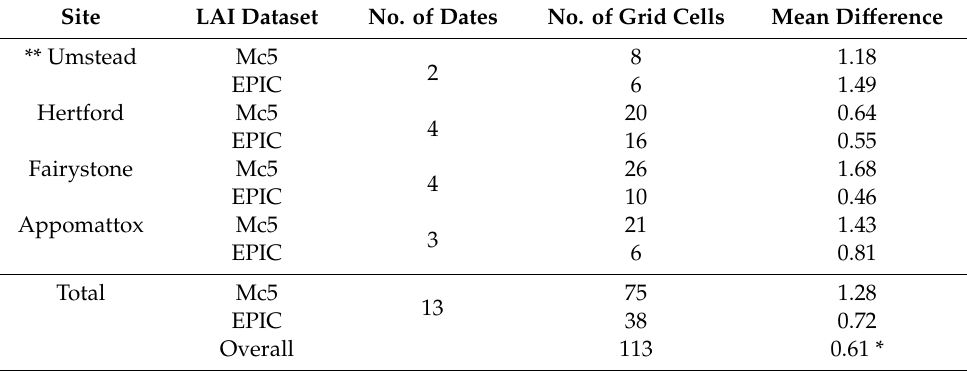
Table 10. 12.0 km grid-based mean differences per LAI site over all EPIC and Mc5 LAI data collections (13).